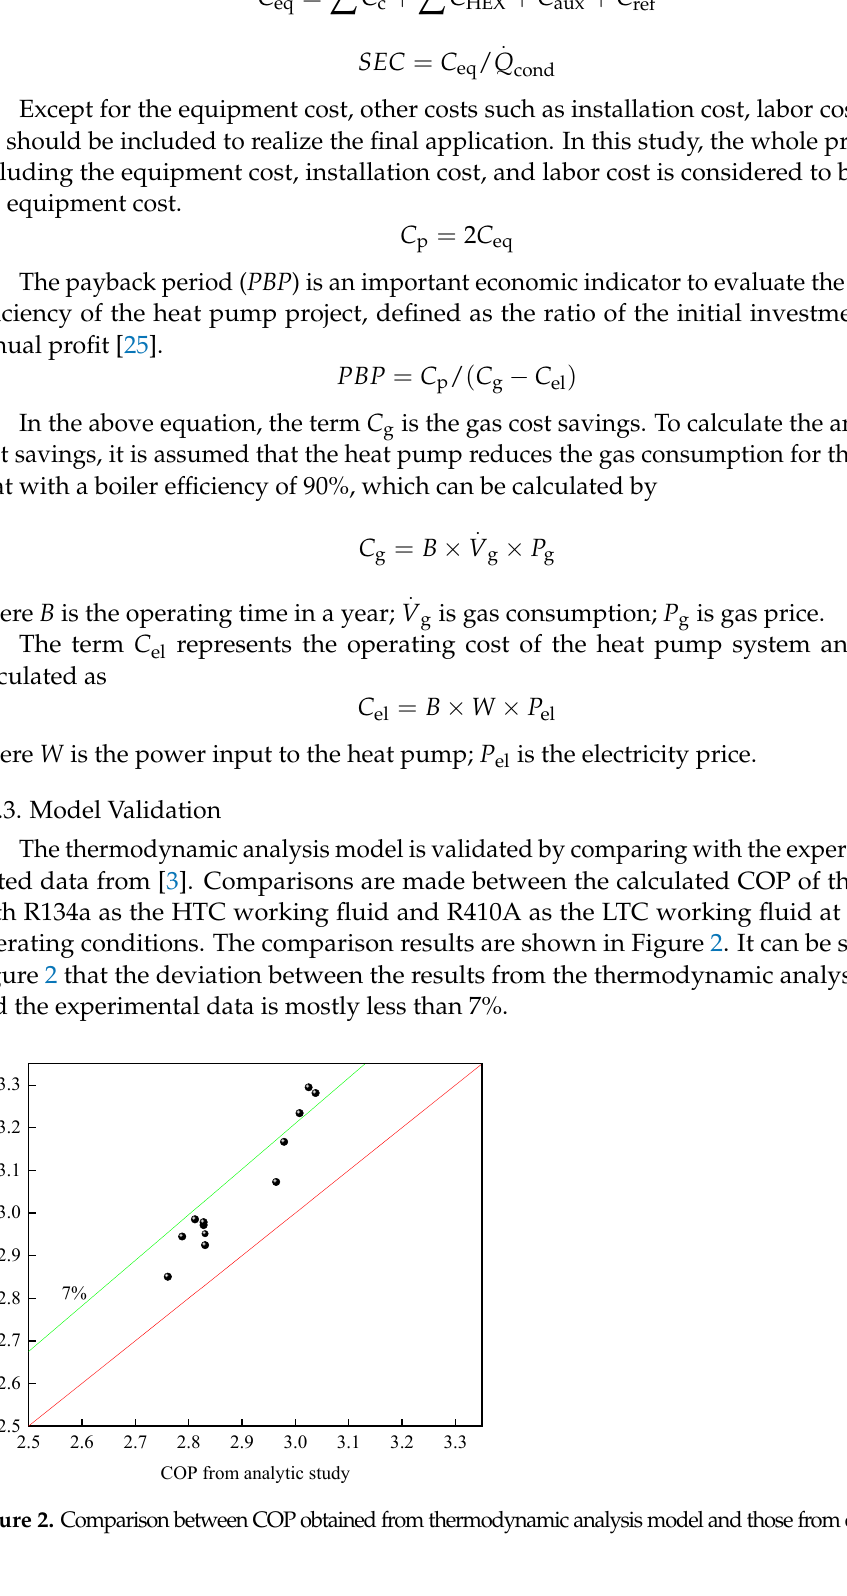
( b ) Figure 3. Effects of the intermediate temperature on the thermodynamic performance. ( a ) COP at various intermediate temperatures. ( b ) Suction volume flow rate at various intermediate temper- atures. Figure 4 shows the effects of the intermediate temperature (IT) on the PBP and SEC. It is identified that there is a certain intermediate temperature for the minimum PBP. The PBP decreases along with the intermediate temperature below the optimal temper- ature, while it increases over the optimal value. The optimal ITs for the PBP are 73.26 °C (PBP = 3.78), 74.3 °C (PBP = 4.77), 75.78 °C (PBP = 6.44) at temperatures of T source /T sink of 40